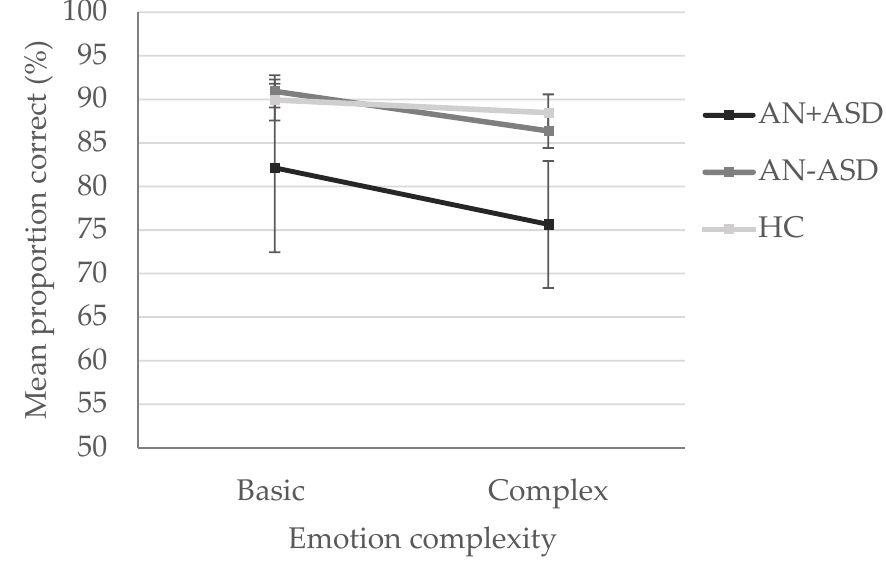
Figure 3. Mean proportion of correct trials on the films expression task. Error bars represent 95% confidence intervals. HC = healthy controls; AN + ASD = lifetime AN, above cut-off on the ADOS-2; AN − ASD = lifetime AN, below cut-off on the ADOS-2.